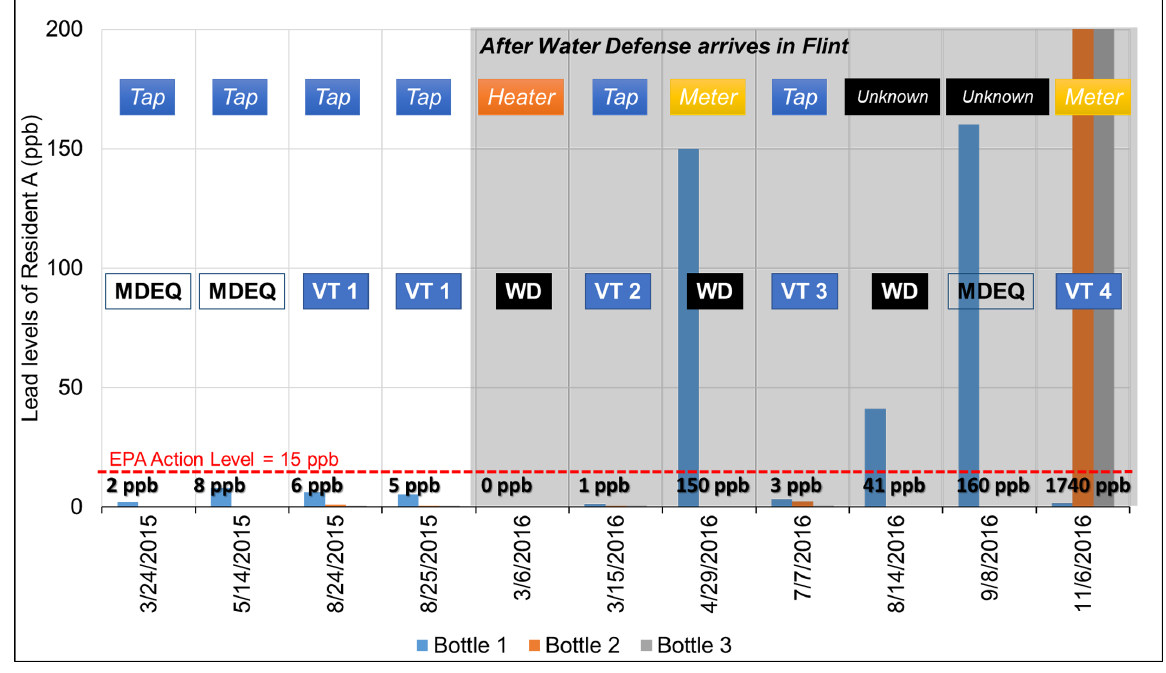
Figure 4: Resident A’s lead levels during the Flint Water Crisis. For every test, the top box indicates the sample collection location base on the resident’s statements and the bottom box shows who coordinated the testing [MDEQ, Virginia Tech = VT, or Water Defense = WD]. The highest lead value obtained per sampling event is stated above the horizontal